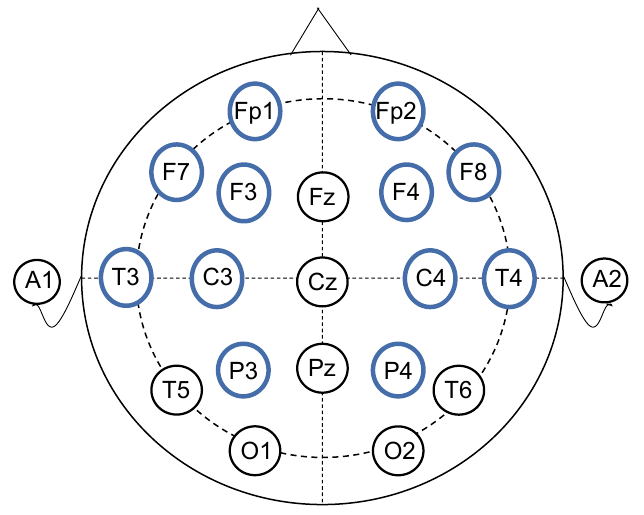
Figure 1. The sampling rate is set at 512 Hz. For each subject, the continuous recorded sleep EEG lasted about 9 h (from 10:30 p.m. to 7:30 a.m.).